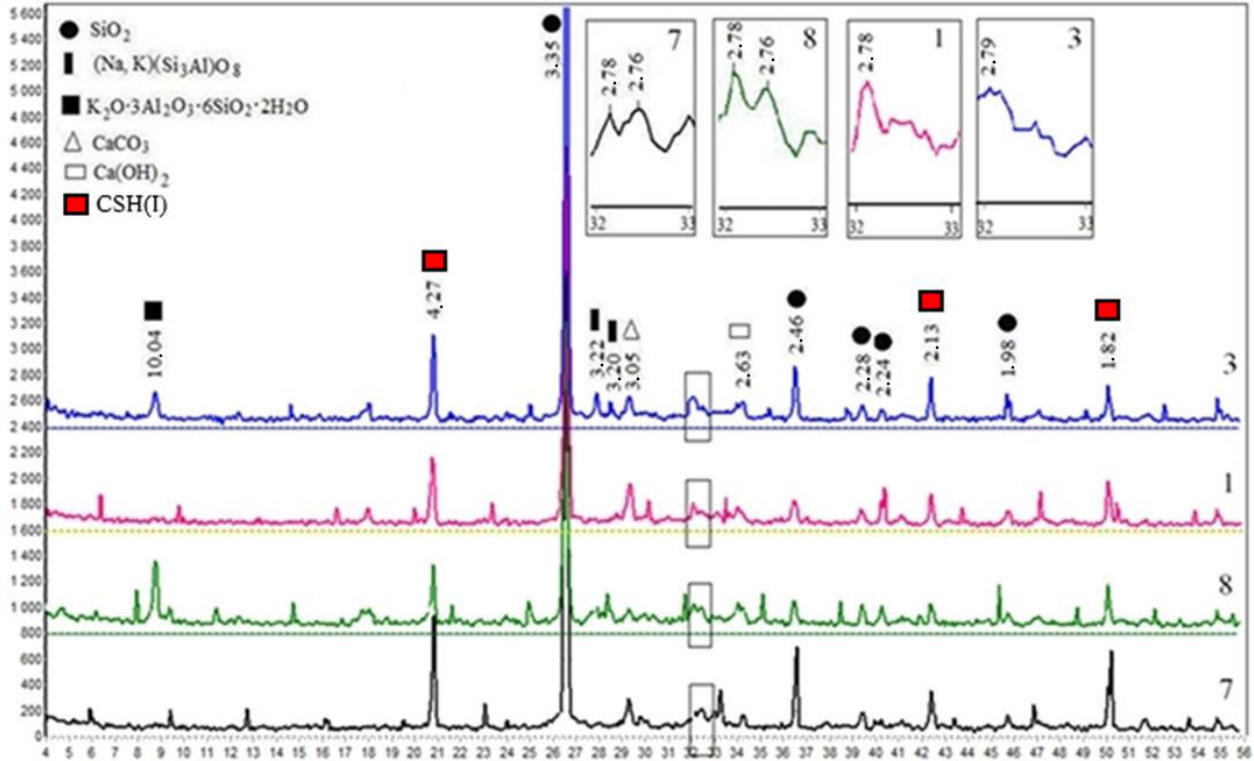
Figure 4. XRD pattern of the specimens CB (1, 3, 7, and 8).